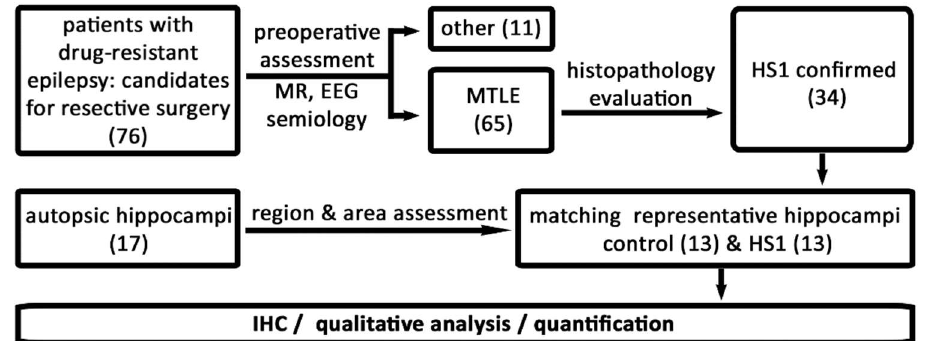
Figure 1. Study design. The study workflow presents the number (in brackets) of cases included throughout the study and further selected for neuropathological and immunohistochemical (IHC) analysis. Out of 34 selected blocks, 13 tissue blocks (38.2%) were both well preserved and had section cut orientation suitable for further analysis. For the IHC part of the study, these 13 HS1 and 13 autopsy tissue samples as control hippocampi were selected. The control group consisted of 13 samples of hippocampal tissue obtained during autopsy within 48 h post-mortem. A neurologist (BS), pathologist (DK), and neuroscientist with expertise in human brain histology (NJM) agreed on the selection of samples based on the suitability of the histological sections for all qualitative and semi-quantitative analyses. MTLE—mesial temporal lobe epilepsy; HS1—hippocampal sclerosis ILAE type 1; IHC—immunohistochemistry.